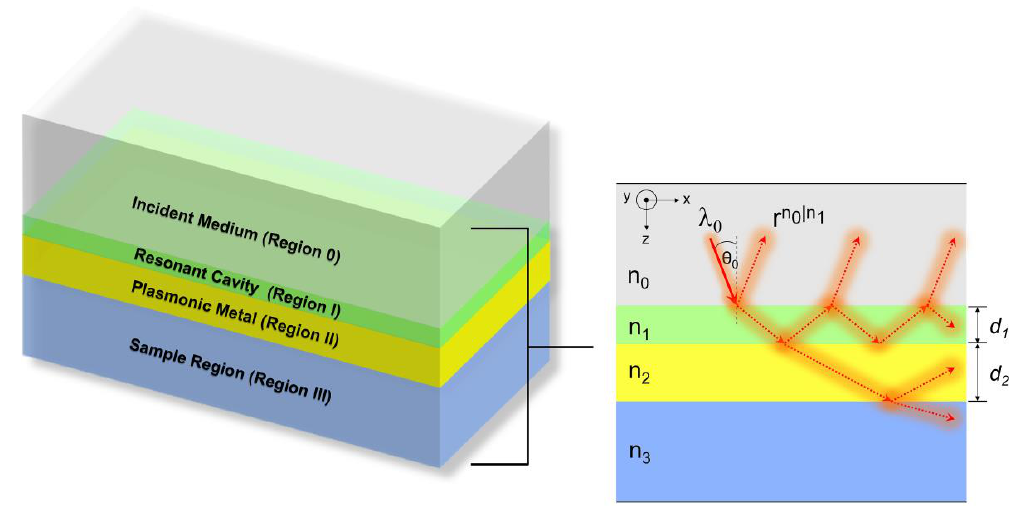
Figure 1. The proposed IIMI structure. The incident medium (Region 0) was a semi-infinite glass substrate with refractive index n 0 serving as an incident medium. The resonant cavity (Region I) was made of a dielectric layer with refractive index n 1 and thickness d 1 . The plasmonic medium (Region II) was a noble metal layer with refractive index n 2 and thickness d 2 . The sample medium (Region III) was also the dielectric layer with refractive index n 3 which was the sample channel of the proposed SPR